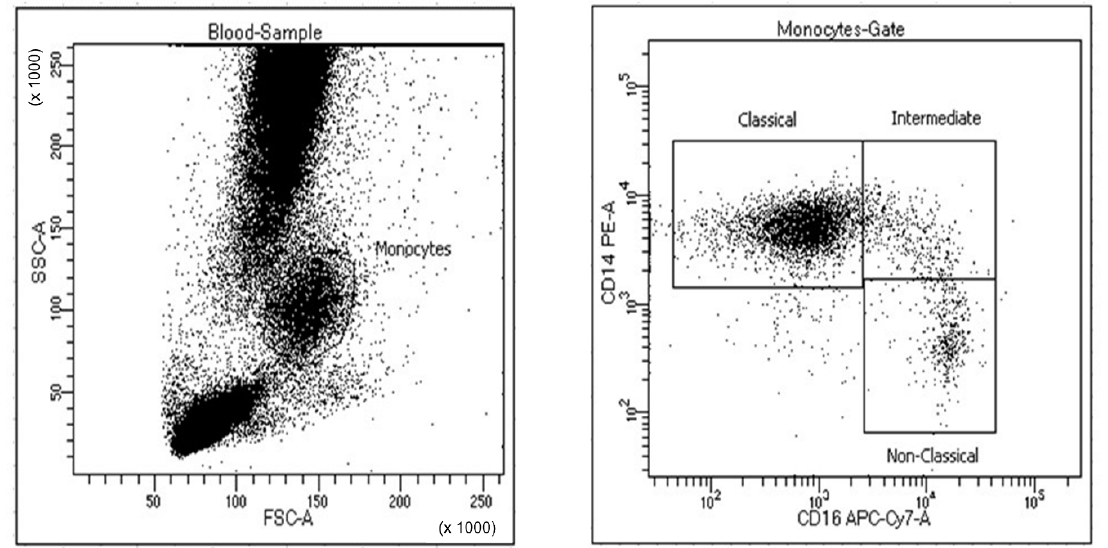
Figure 1. Flow cytometry gating for monocyte CD14++CD16+ cells from a sample obtained by FNAB.